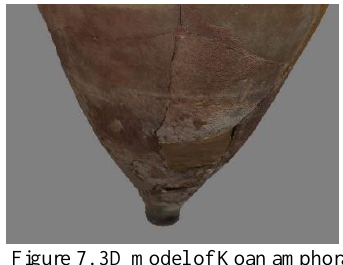
Figure 7. 3D model of Koan amphora